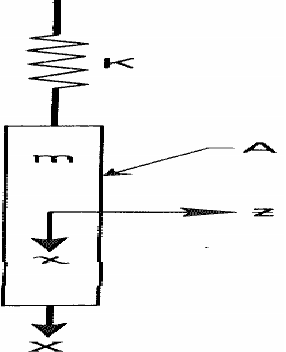
Figure 1. The immersed